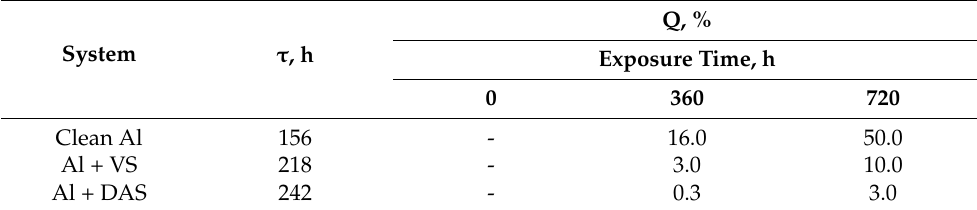
Figure 7. Photographs of the appearance of clean surface of Al and modified with organosilane films, after their exposure in the climatic chamber for 720 h. Table 2. The proportion of corrosion damage Q and time to occurrence of the first defect τ on clean and modified aluminium organosilane films during exposure of samples in the climatic chamber for 720 h.